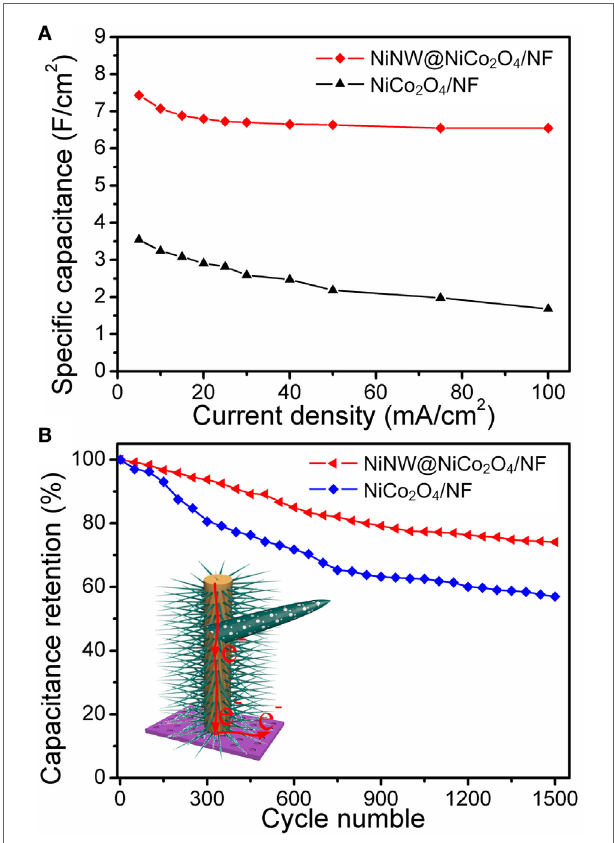
FigUre 6 | (a) Specific capacitance values of NiCo 2 O 4 /NF and NiNW@ NiCo 2 O 4 /NF as a function of current densities. (B) Cycling performance at progressively varying current